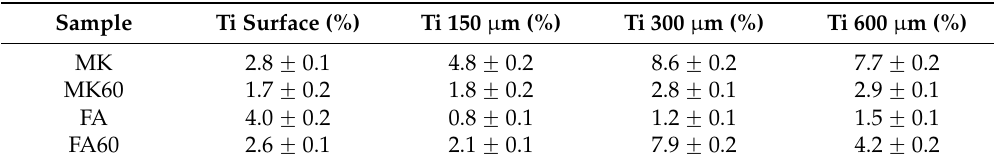
Figure 6. SEM images of internal section at 2000 magnifications of ( A ) MK and ( B ) FA samples. In order to assess the titania distribution on the sample, the relative titanium content on the surface and at different depths along the specimen section was measured with SEM/EDS (Table 3). Table 3. Relative titanium content for selected samples (energy dispersive X-ray spectrometry (EDS)